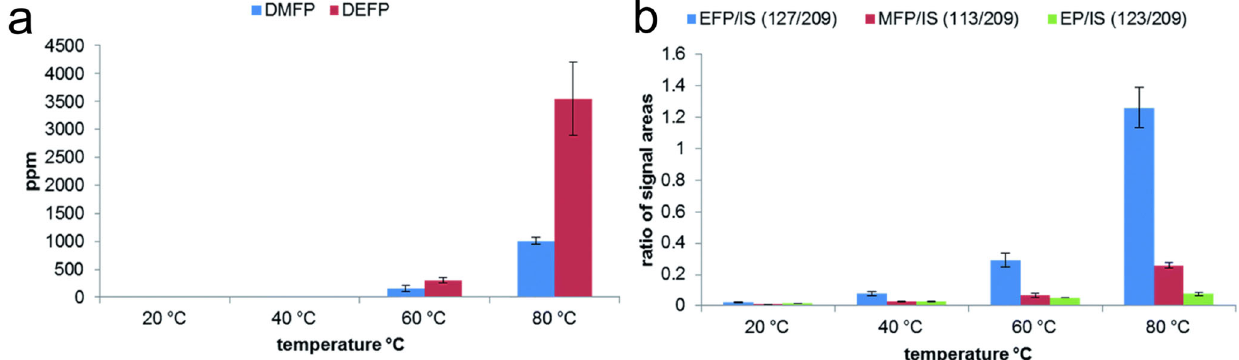
Fig. 3 Storage performance of electrolytes at different temperatures. Analysis of the organic phosphate (dimethyl fl uorophosphate [DMFP], diethyl fl uorophosphate [DEFP], methyl fl uorophosphate [MFP], ethyl fl uorophosphate [EFP] and ethylene phosphate [EP]) formation by ( a ) GC-MS and ( b ) IC- ESI-MS in 10 mL aluminum vials after aging at different temperatures for 21 days. Reproduced with permission from reference 41 , copyright (Royal Society